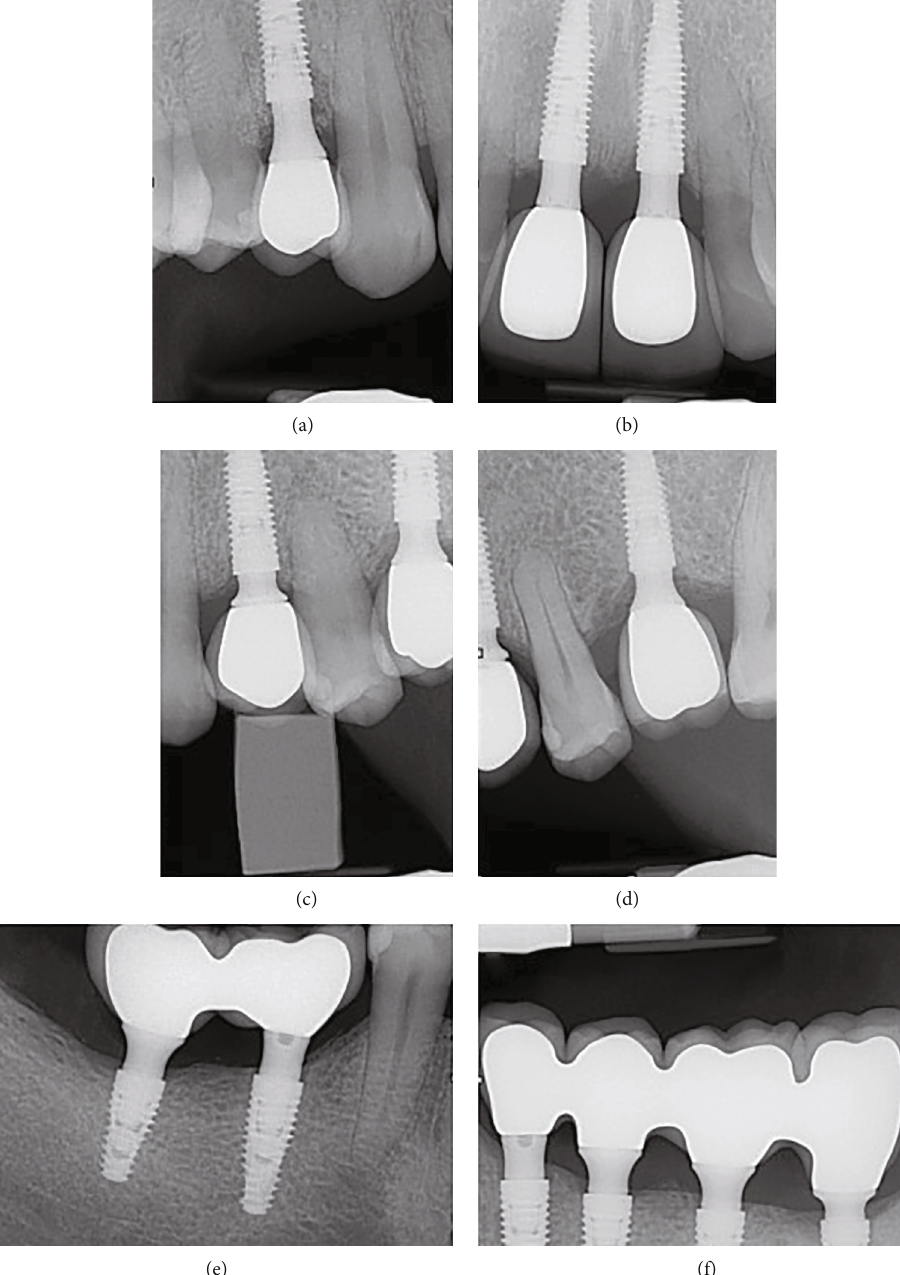
Figure 6: Periapical X-rays after maxillary (a) – (d) and mandibular (e, f) de fi nitive prosthesis